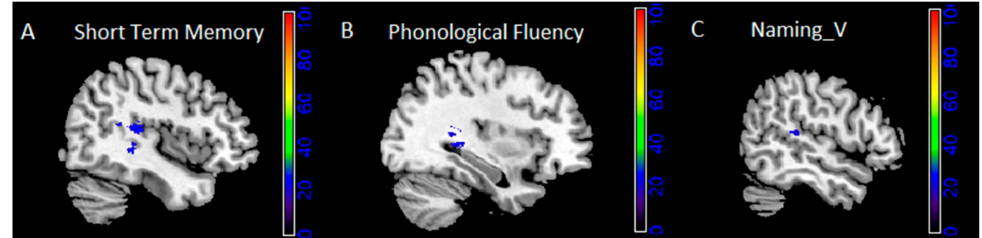
Figure 2. Subtraction of lesion masks of patients scoring pathologically from patients with normal performance (minimum 20% overlap) on the different tasks: short-term memory ( A ), phonological fluency ( B ) and verb naming ( C ) MR images are displayed following radiological convention (left is right and vice versa). V =